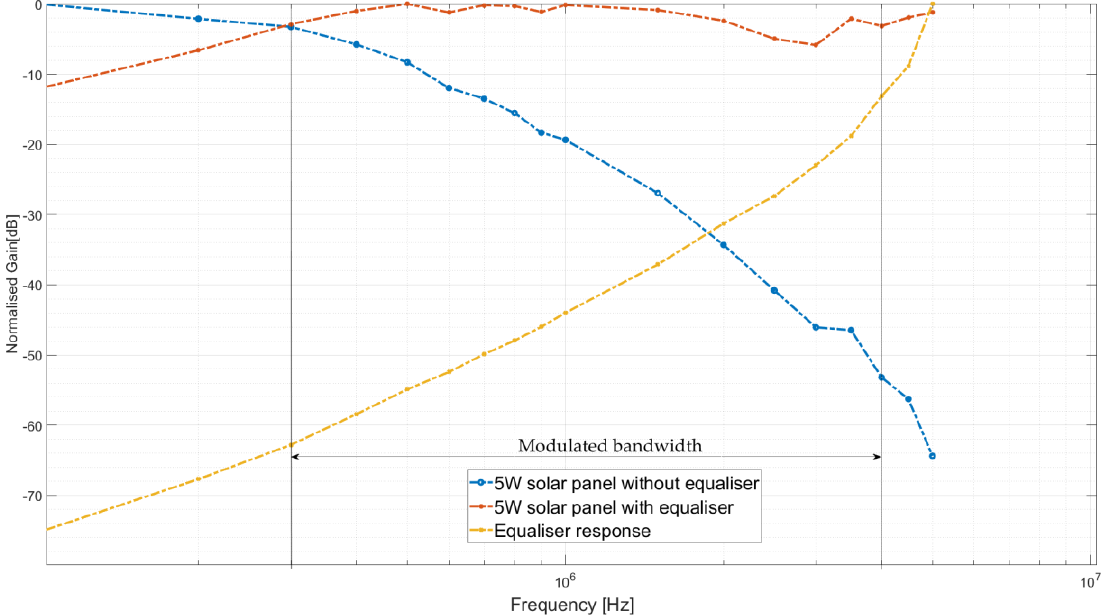
Figure 12. Frequency response of the solar panel with and without equalisation.